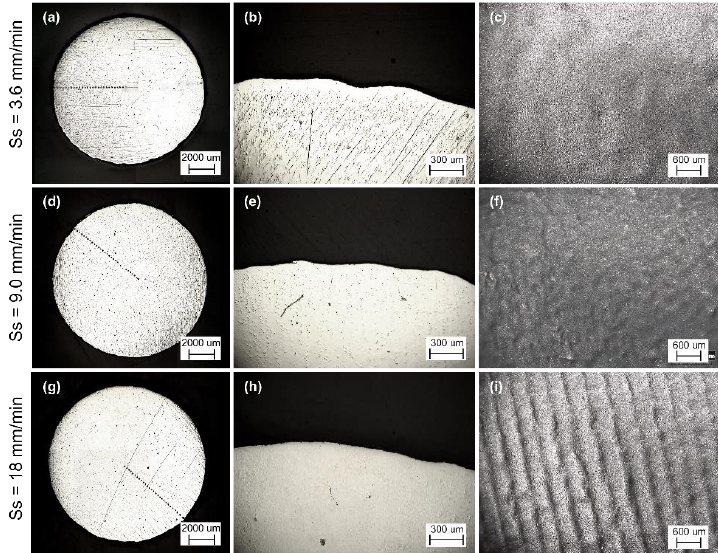
Figure 6. ( a , d , g ) Cross-sections, ( b , e , h ) their magnifications, and ( c , f , i ) surface morphologies after laser polishing at different Ss and Fd = 5 mm.